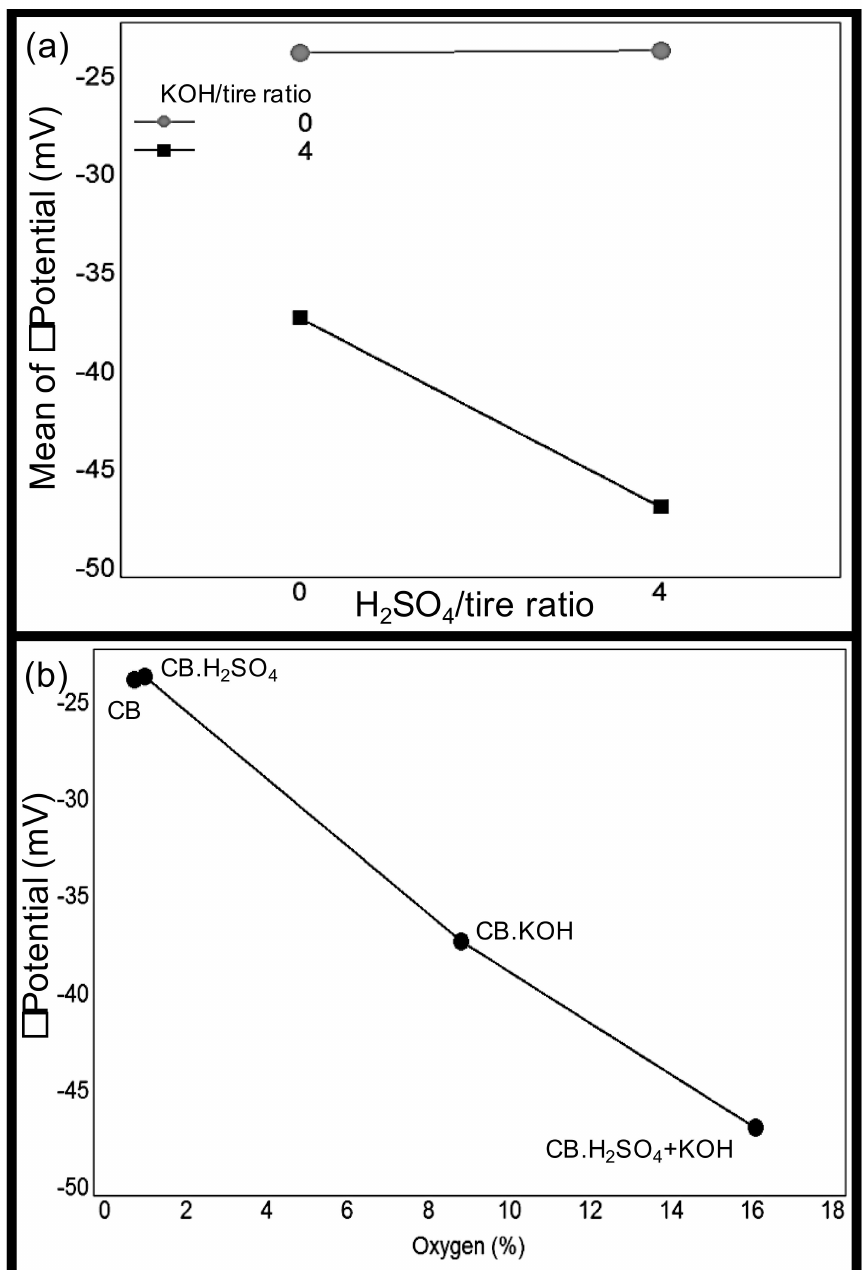
Figure 7. Results of ζ potential analysis. ( a ) Interaction plot showing the KOH activation e ff ect increasing the ζ potential and ( b ) oxygen content e ff ect on the ζ potential of carbon black